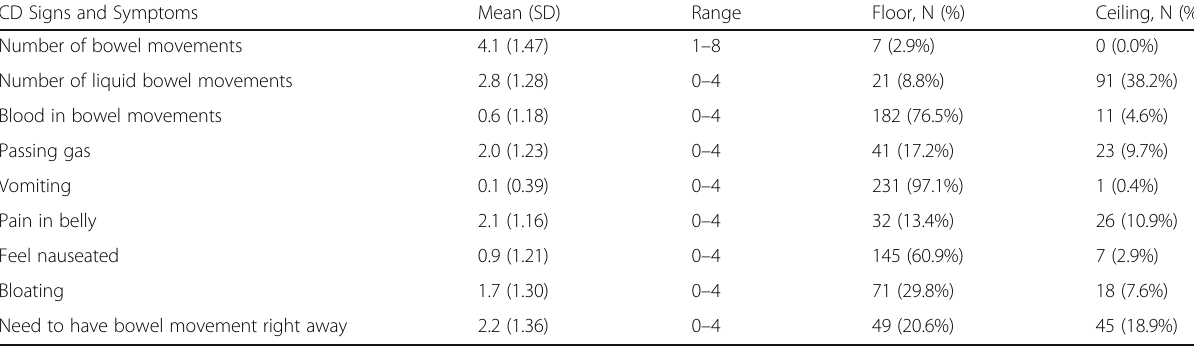
Table 2 Item Descriptive Characteristics CD-PRO/SS a ( n = 238) CD Signs and Symptoms